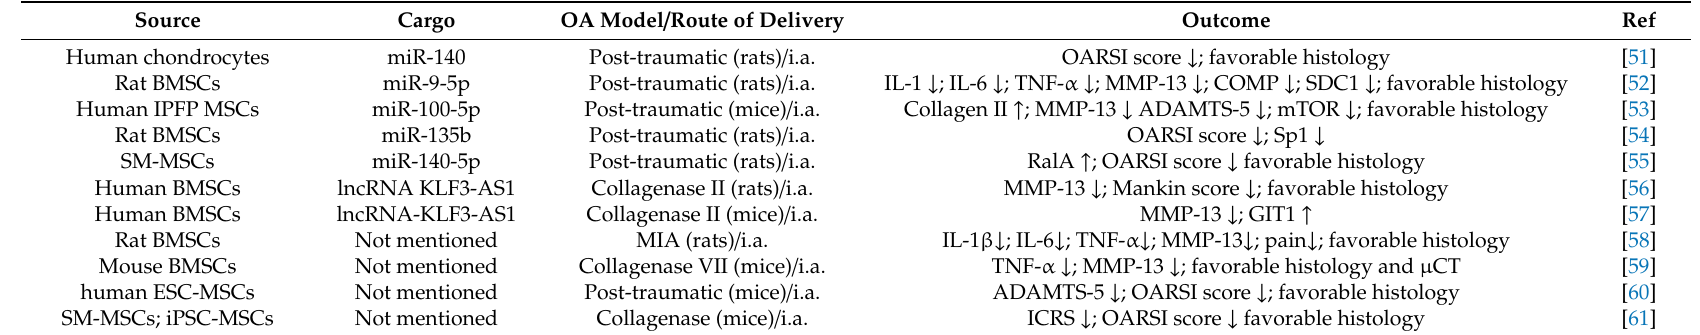
Table 2. The therapeutic e ff ects of exosomes derived from di ff erent sources for